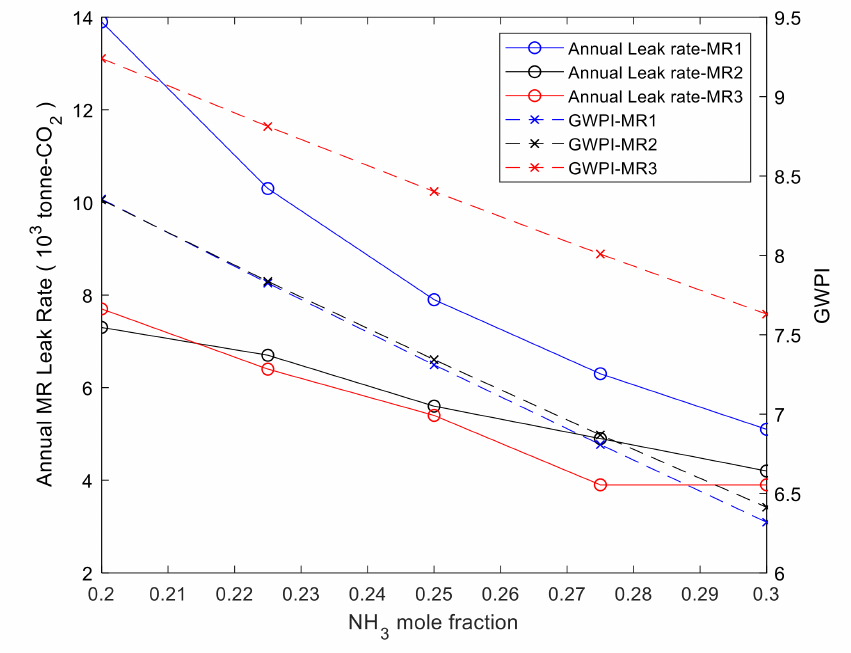
Figure 10. GWPI and annual leak rates of each case study in MR-1, MR-2 and MR-3.